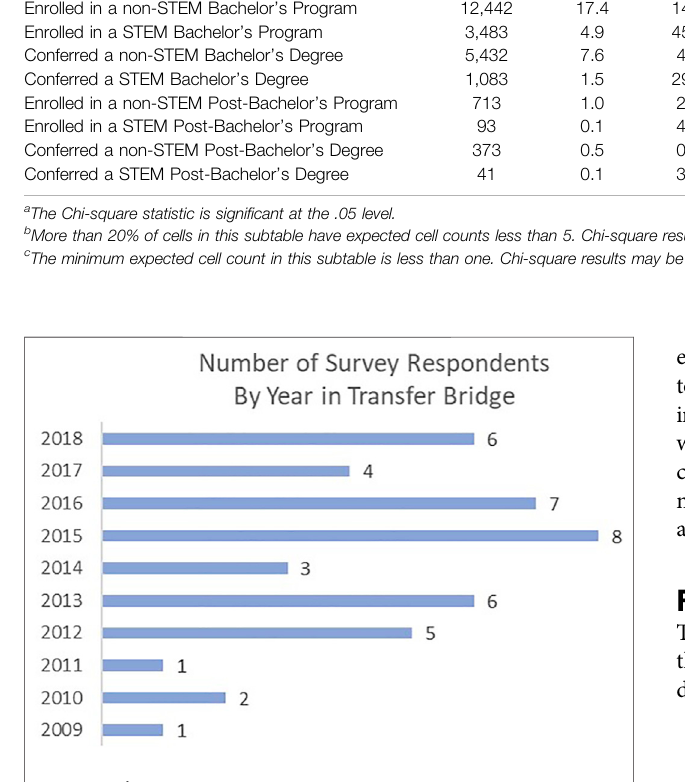
FIGURE 2 | Number of survey respondents by year in transfer bridge